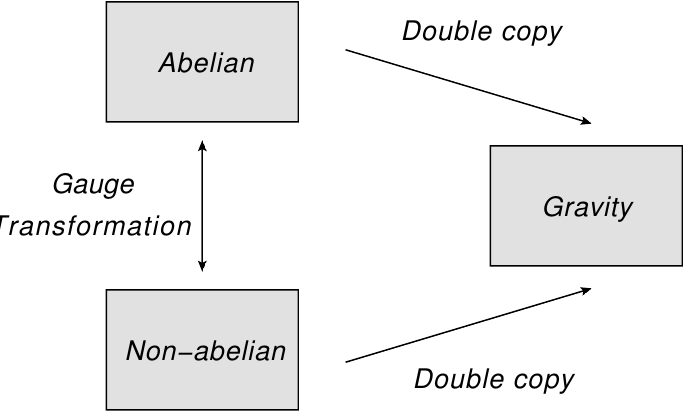
Figure 2 . Generalisation of the Kerr-Schild double copy, in which one may identify abelian or non-abelian exact solutions of a gauge theory with the same gravity